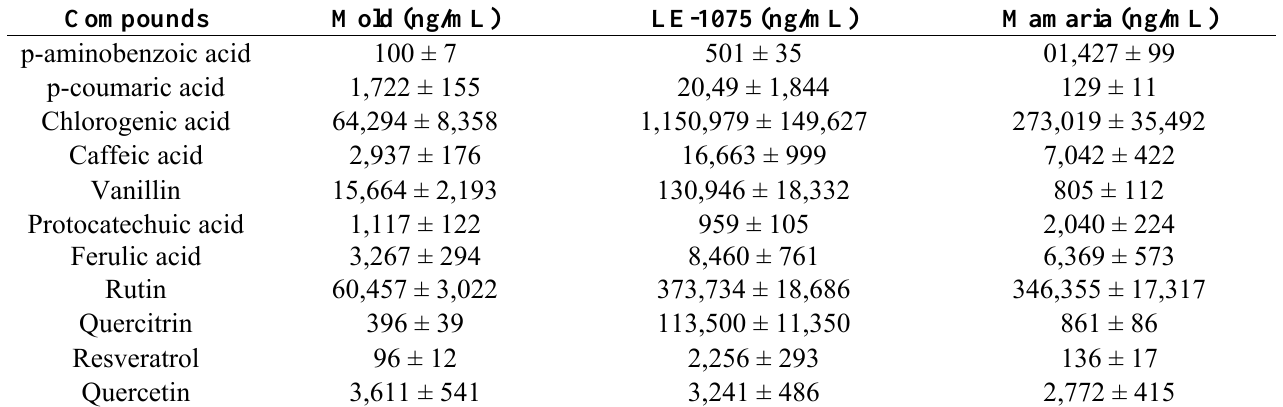
Table 11. Analytical